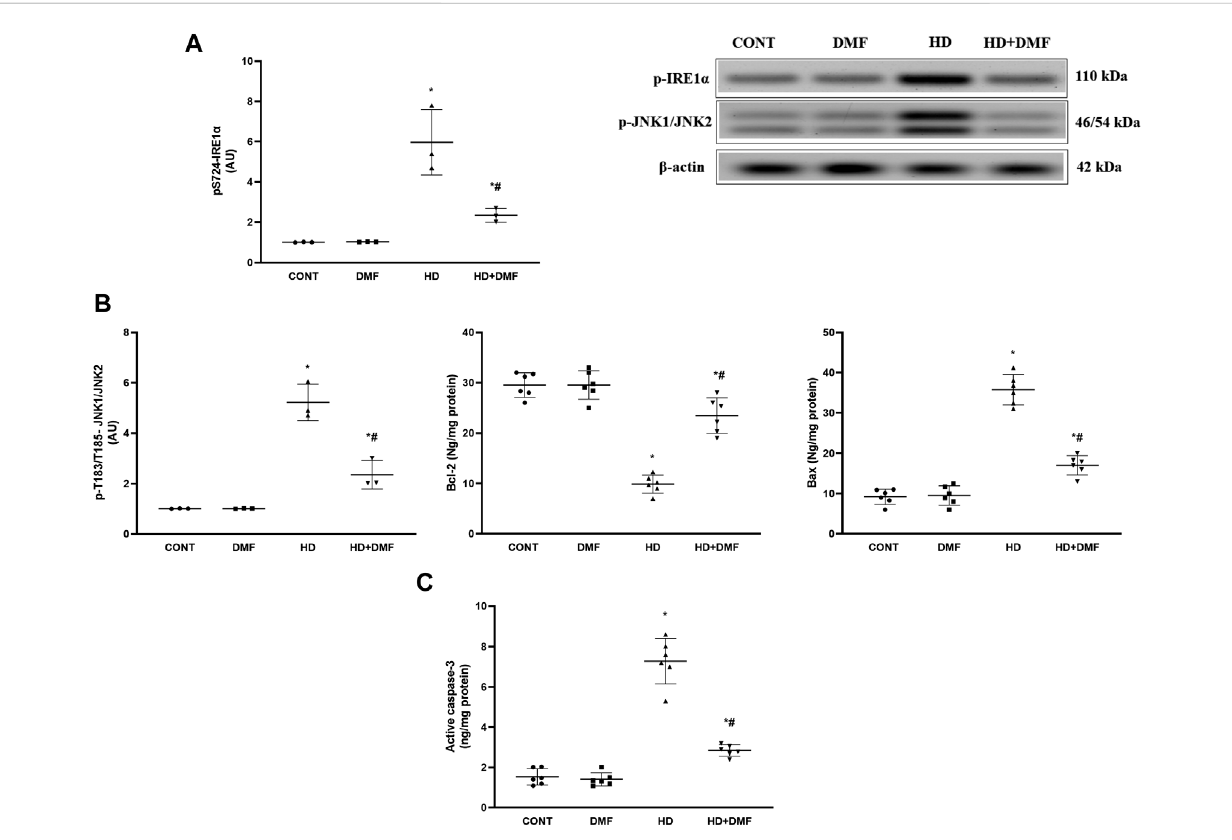
Effect of DMF on the striatal protein expression/content of (A) p-IRE1 α ; (B) p-JNK1/JNK2, Bcl-2, and Bax; and (C) active caspase-3 in HD rats. Data are represented as mean ± SD ( n = 3 rats/group for WB; n = 6 rats/groupfor ELISA) using one-way ANOVA, followed by Tukey ’ s post hoc test *vs. CONT and # vs. HD at p < 0.05. Bax, B-cell lymphoma-2-associated X; Bcl-2, B-cell lymphoma-2; CONT, control; DMF, dimethyl fumarate; HD, Huntington ’ s disease; IRE1 α , inositol-requiring enzyme 1 alpha; JNK, c-Jun NH2-terminal